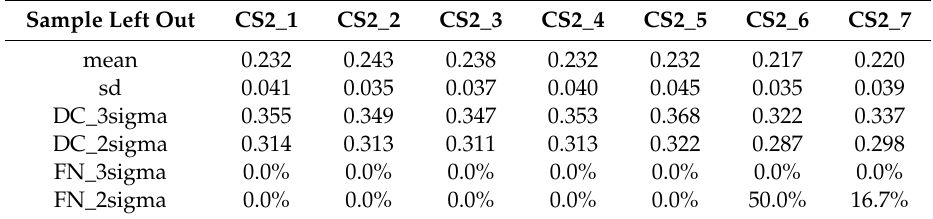
Table 5. Performance data of the leave-one-out approach for reference samples of case study 2. Sample Left